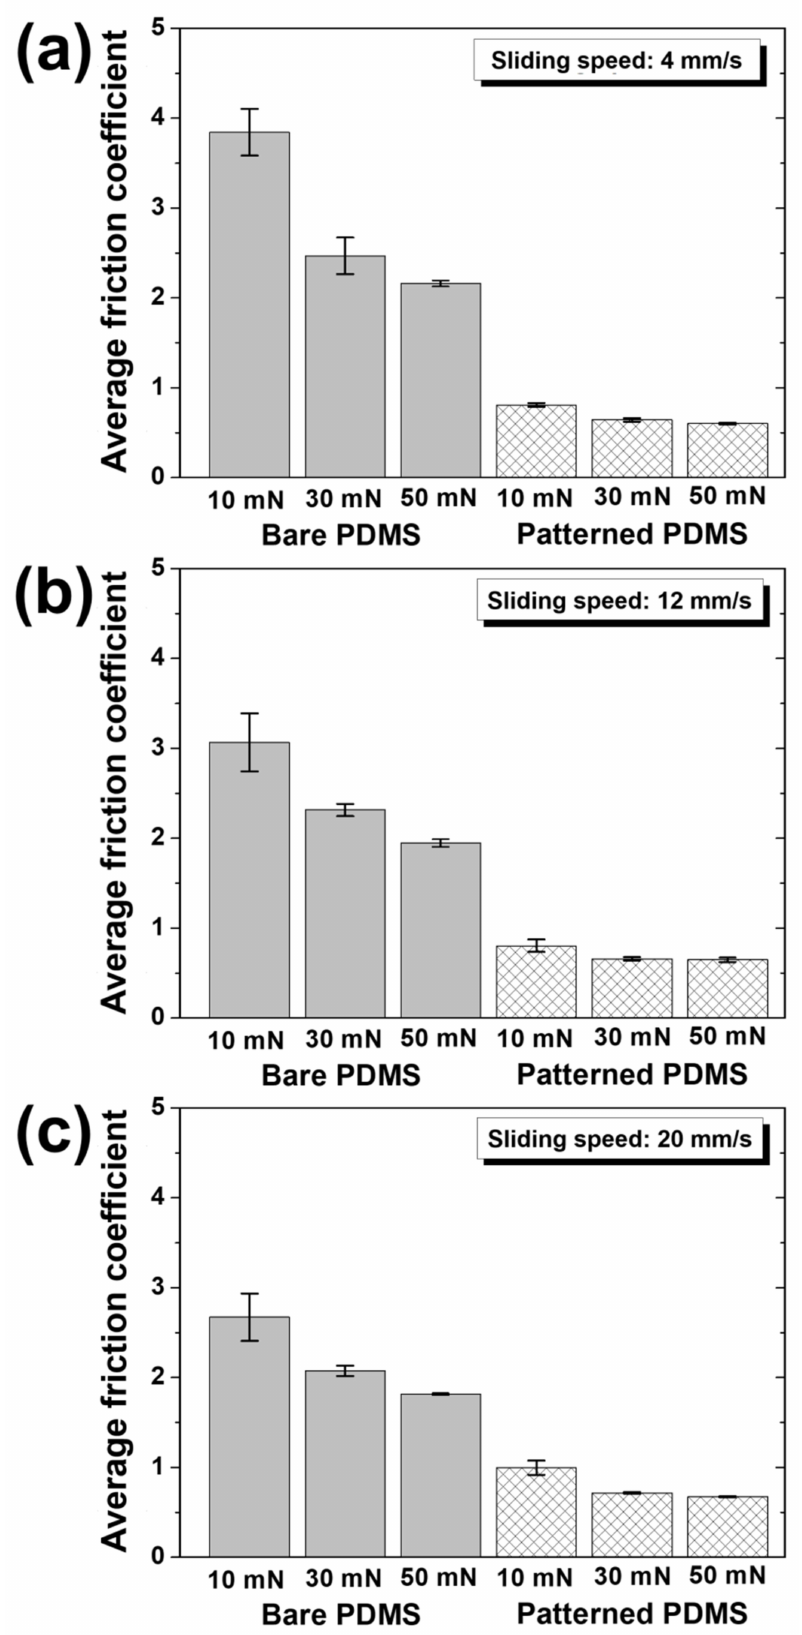
Figure 9. Average friction coefficients as a function of normal load at sliding speeds of ( a ) 4 mm/s, ( b ) 12 mm/s, and ( c ) 20 mm/s for bare PDMS and micro/nanopatterned